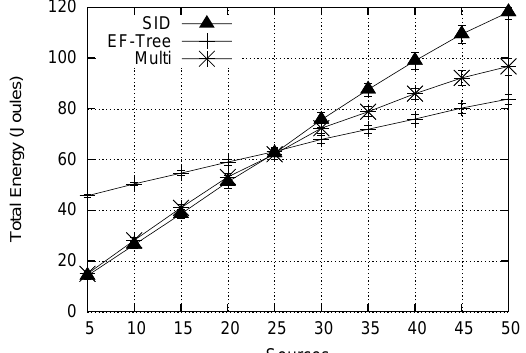
Figure 9. Performance of Multi-MAF under different traffic